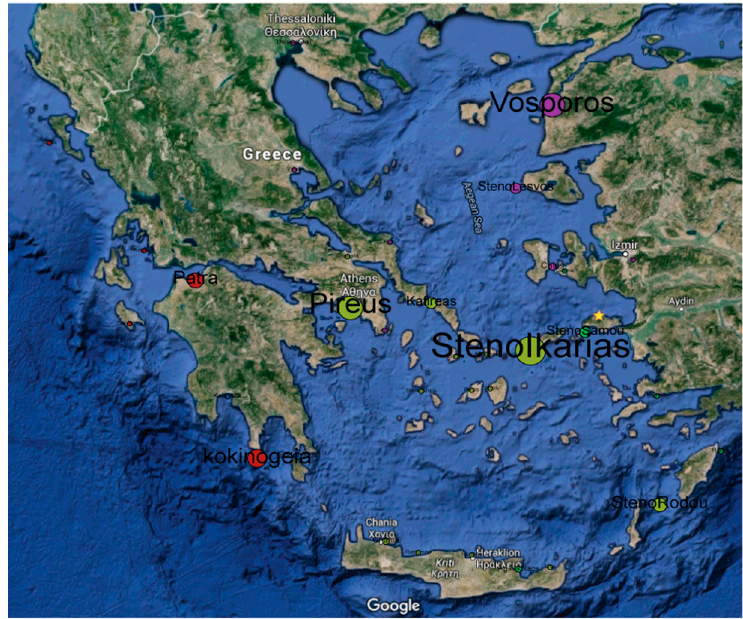
Figure 16. The network of Figure 15, layered upon a Google map of the area.